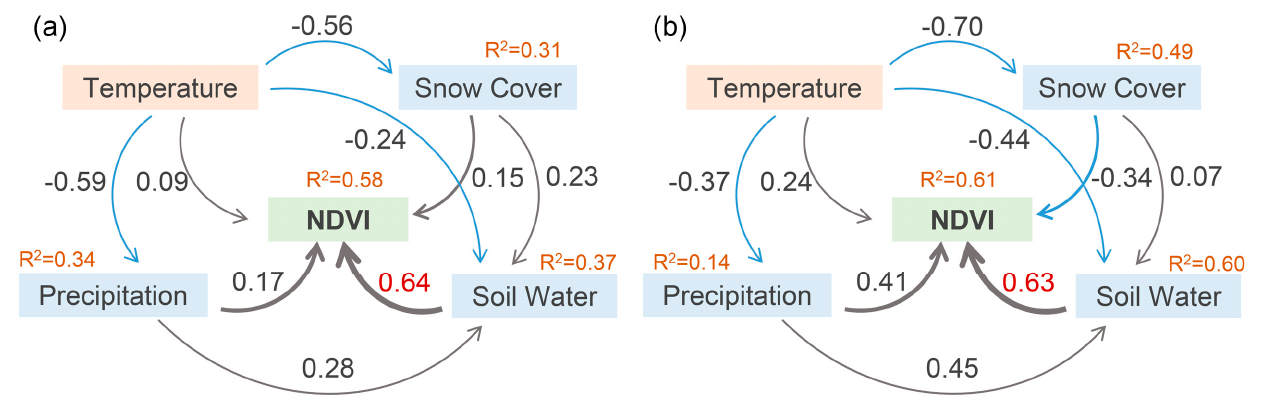
Figure 5. Direct and indirect effects of temperature, snow cover, precipitation, and soil water on NDVI in areas lower than 300 m ( a ) and higher than 300 m ( b ). Gray arrows represent positive correlations, blue arrows represent negative correlations, and thicker arrows represent larger PCs. Table 2. The total, direct and indirect effects of temperature (Tmp), precipitation (Pre), snow cover (Snow C), and soil water (Soil W) on NDVI at different elevation gradients and time scales. Growing Season (Elevation < 300 m: